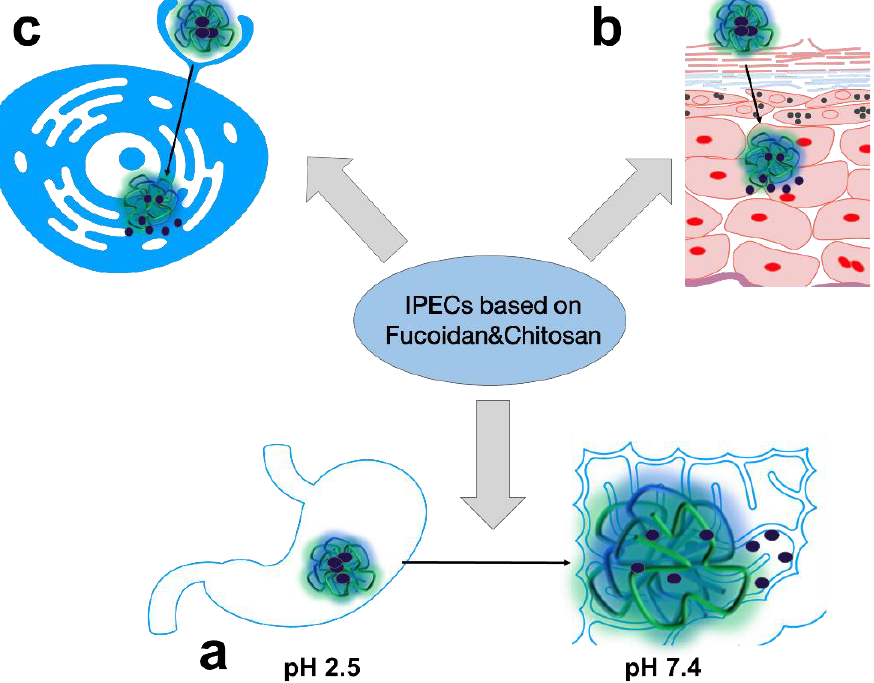
Figure 3. The main trends in pharmaceutical R&D of PECs based on FUC and CS: oral ( a ); topical ( b ) and targeted ( c ) drug delivery systems.